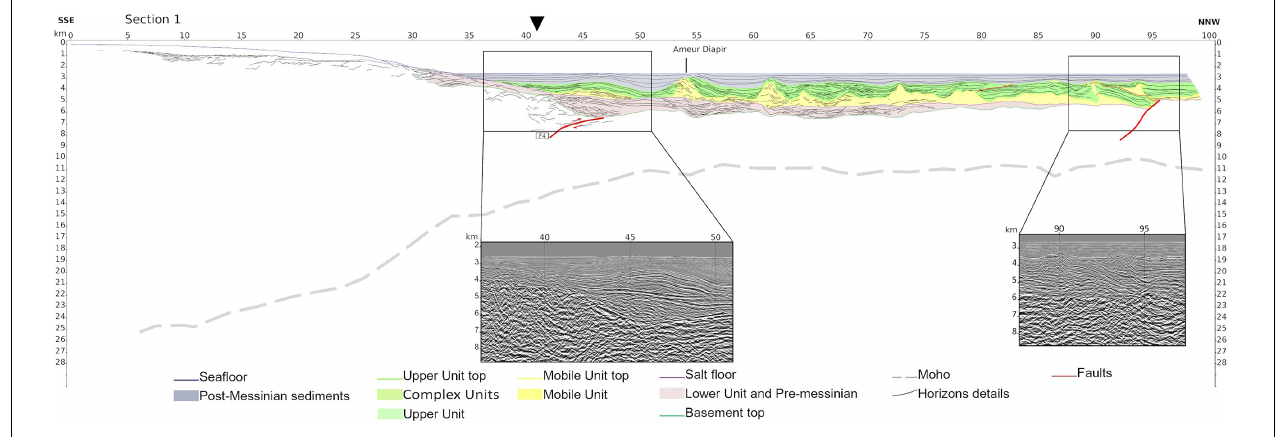
FIGURE 3 | Seismic section 1 (Mostaganem) as a depth-converted line drawing. No vertical exaggeration is present. Major horizons and faults are identified. No major asymmetric basins are identified on this section. The two insets display raw depth-converted extractions of the seismic line. Downward pointing arrow locates the ocean-continent transition.